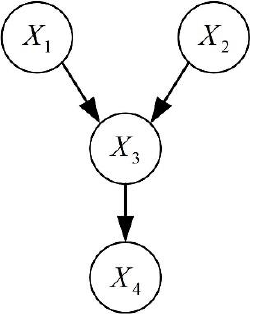
Figure 1. Basic BN structure.